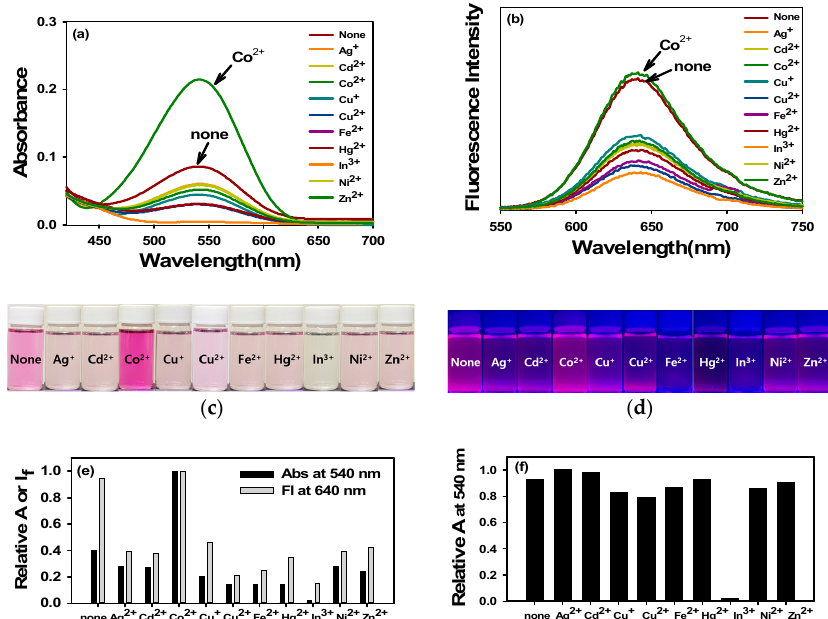
Figure 5. ( a ) Absorption spectra, ( b ) fluorescence spectra, ( c ) photograph of visual color change, ( d ) photograph of fluorescence change, and ( e ) relative absorbance and fluorescence intensity of SP-IQ after 350 nm UV irradiation for 7 min with the addition of various metal cations; and ( f ) relative absorbance of SP-IQ after 350 nm UV irradiation for 7 min with the addition of various metal cations (1 × 10 − 4 M; Ag 2+ , Cd 2+ , Cu + , Cu 2+ , Fe 2+ , Hg 2+ , In 3+ , Ni 2+ , Zn 2+ ) in the presence of Co 2+ (1 × 10 − 4